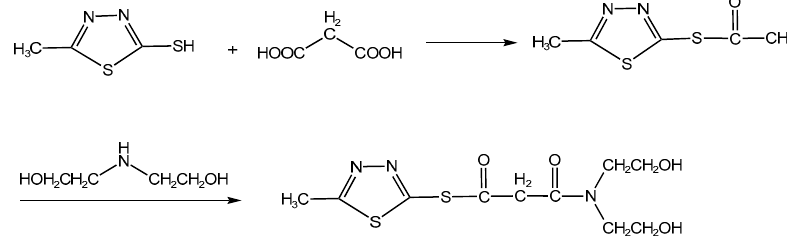
Figure 1. The synthesis route of